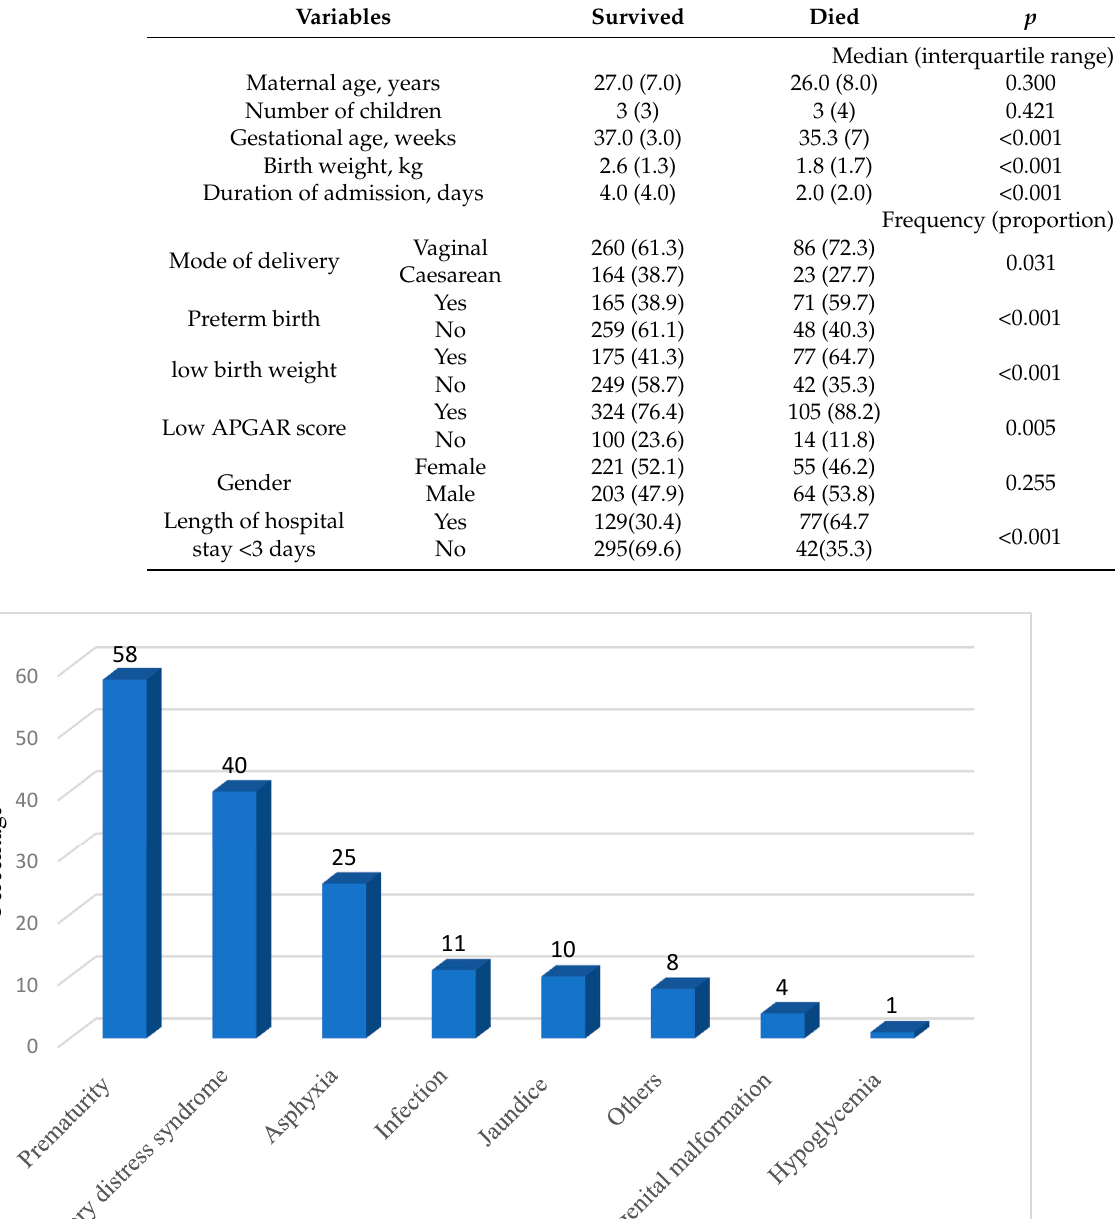
Table 2. Comparison between newborns who died and survived in the neonatal intensive care unit of Gadarif hospital (N = 543).